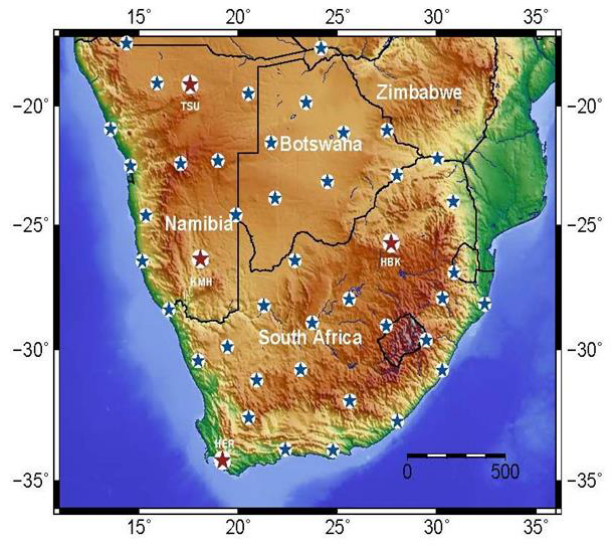
Figure 6. A map of southern Africa showing the positions of the four INTERMAGNET observatories, Hermanus (HER), Harte- beesthoek (HBK), Keetmanshoop (KMH) and Tsumeb (TSU) (red stars), as well as the positions of the field survey repeat stations (blue stars).